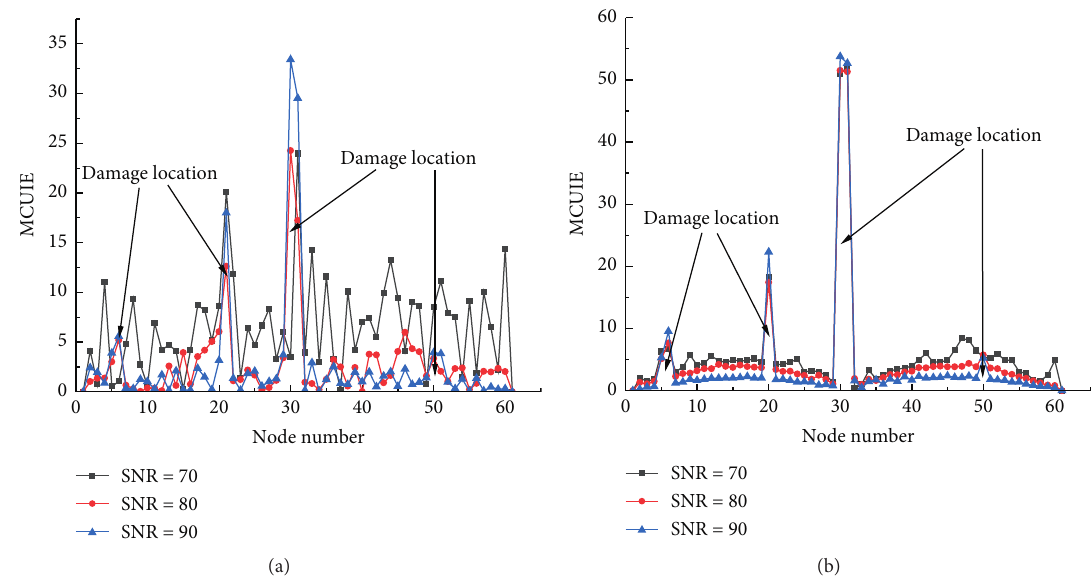
Figure 16: Antinoise verification of MCUIE index. (a) Antinoise verification of first-order. (b) Antinoise verification of